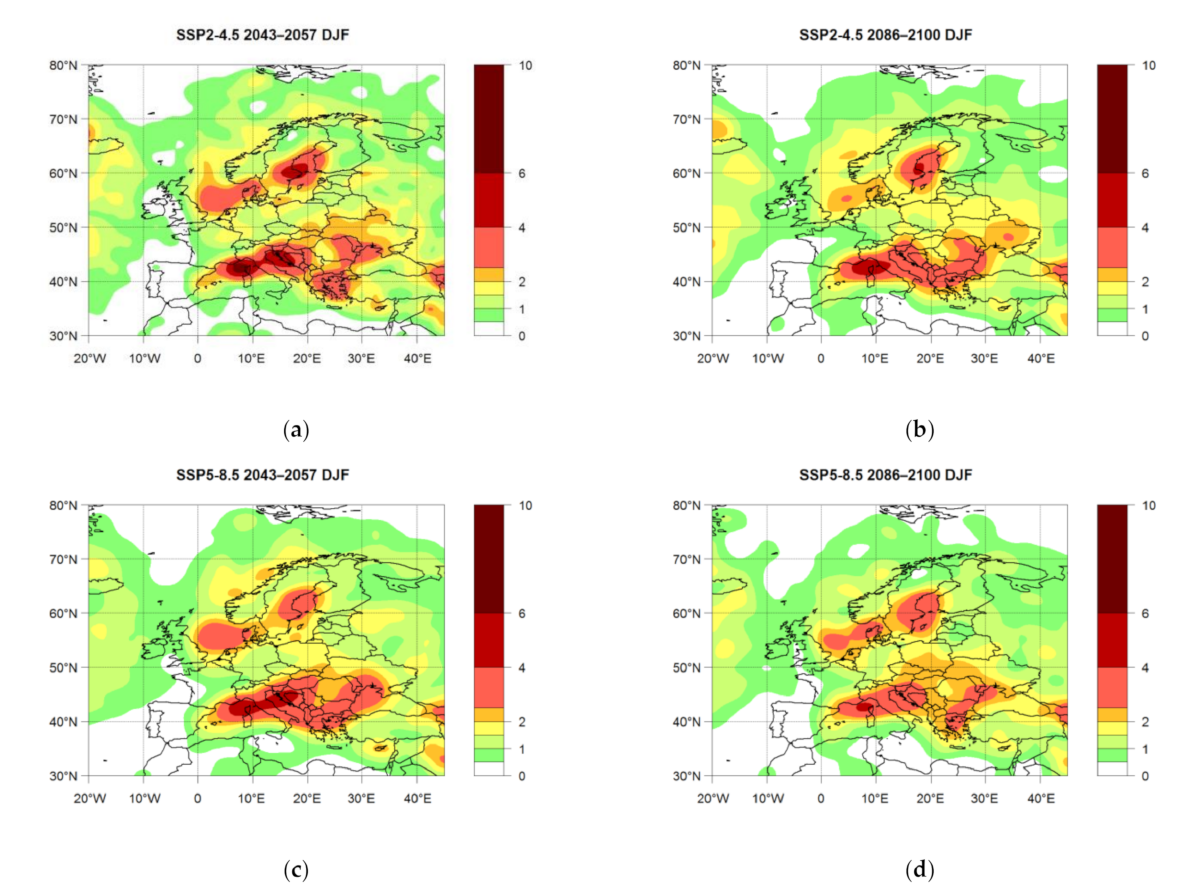
Figure 4. Number of winter cyclogenesis events (total for 15 seasons) according to the ensemble of the CMIP6 models: ( a , c ) at the middle of the 21st century; ( b , d ) at the end of the 21st century; ( a , b ) under the SSP2-4.5 scenario; and ( c , d ) under the SSP5-8.5